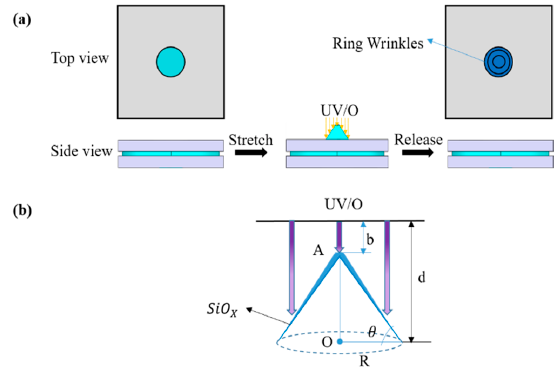
Figure 5. Schematic illustration of the production of concentric ring wrinkles with continuously changing wavelength. ( a ) The center of the substrate was extended upward using a cone and simultaneously treated with UV/O 3 . Concentric wrinkles with continuously changing wavelength were generated after the removal of the cone. ( b ) The thickness gradient of the film was controlled by the distance between the lamp and PDMS substrate d .